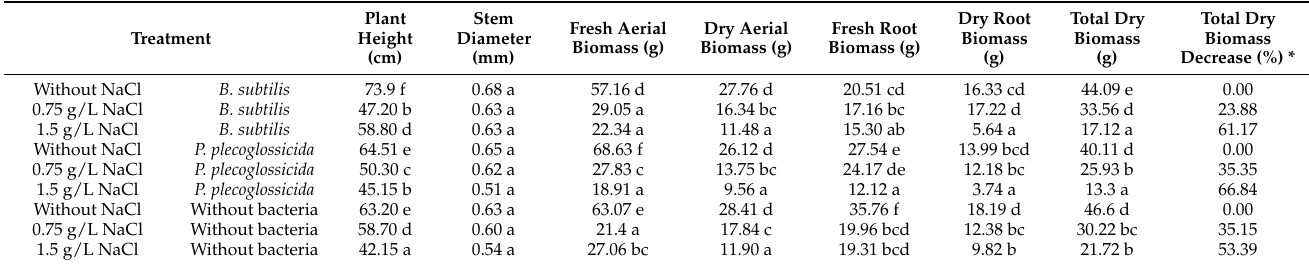
Table 2. Growth parameters of Persea americana var. Zutano inoculated with PGP bacteria under salinity stress conditions.